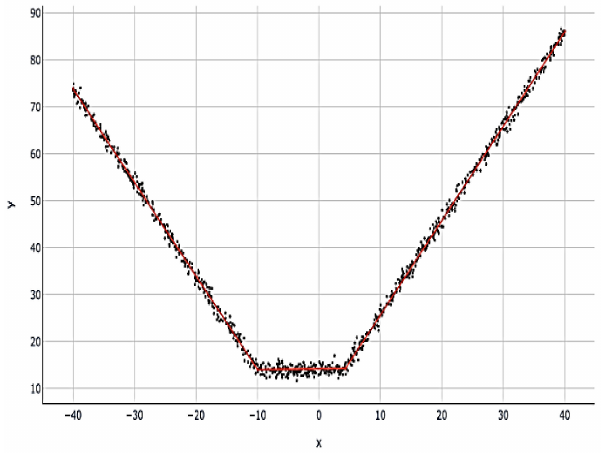
Figure 2. Example of a MARS model